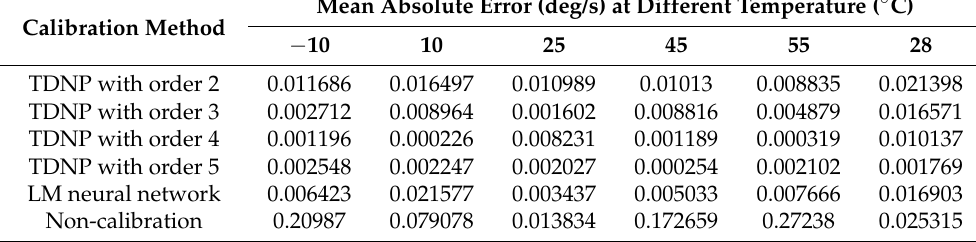
Table 2. Mean absolute error of different methods (070077).